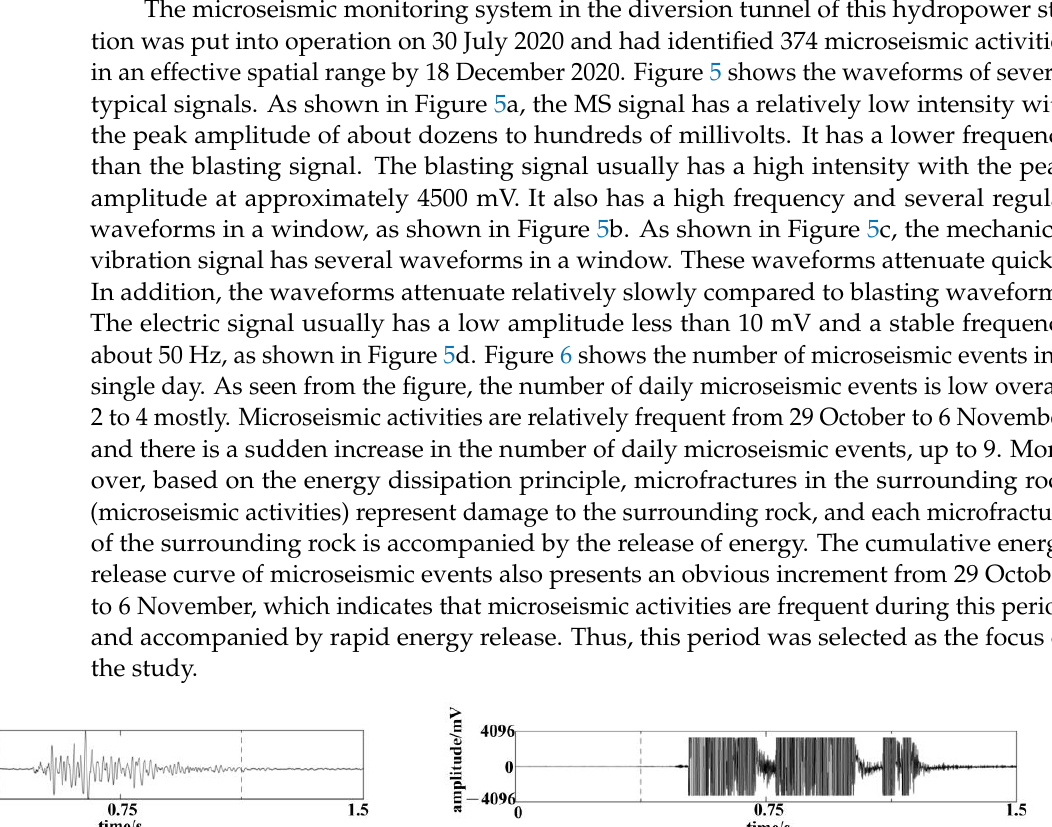
Figure 5. Waveforms of typical signals.